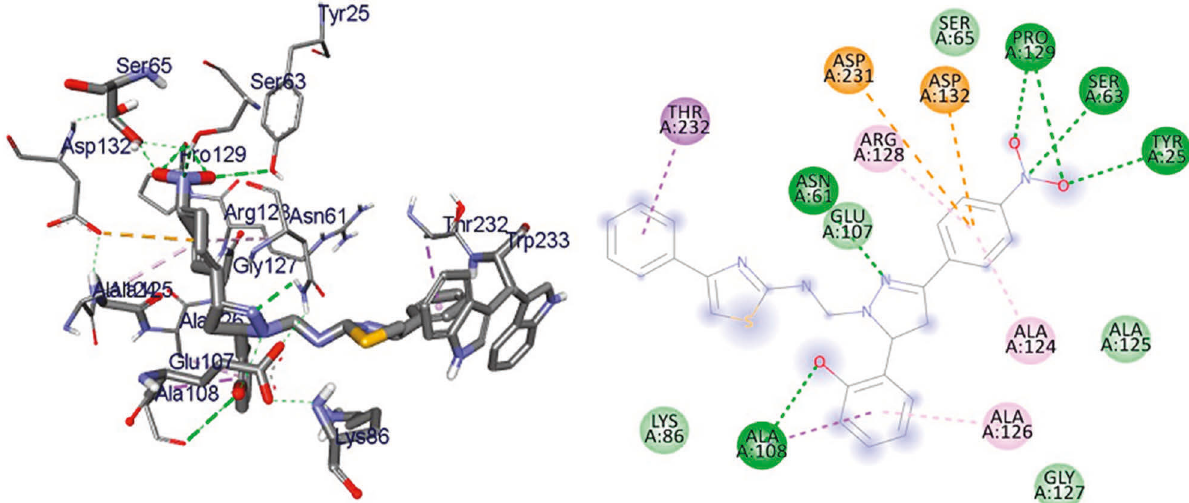
Figure 6: 3D (a) and 2D (b) representations of the binding interactions of 22 against the N-terminal domain of